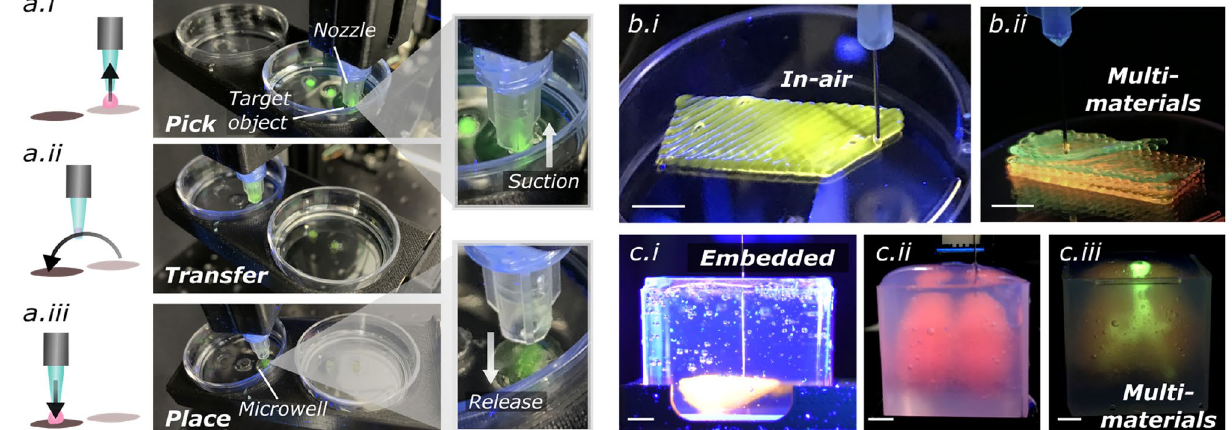
Figure 5. ( a ) Automatic pick-and place-operation, showing ( i ) the pick-up, ( ii ) transfer and ( iii ) placement of the printed objects to the targeted micro-wells. The printed objects composed of 6 w/v% gelatin and 1 w/v% alginate were stained with sodium fluorescein and a UV touch was used for illustrating the objects. ( b ) In-air printing of ( i ) a Pluronic F127 ink and ( ii ) multiple Pluronic inks stained with different colours. ( c ) Embedded printing of a sodium hyaluronate ink in a Carbopol bath and ( ii ) multiple alginate inks stained with different colours in a xanthan gum bath for forming a lung structure. Scale bars = 5